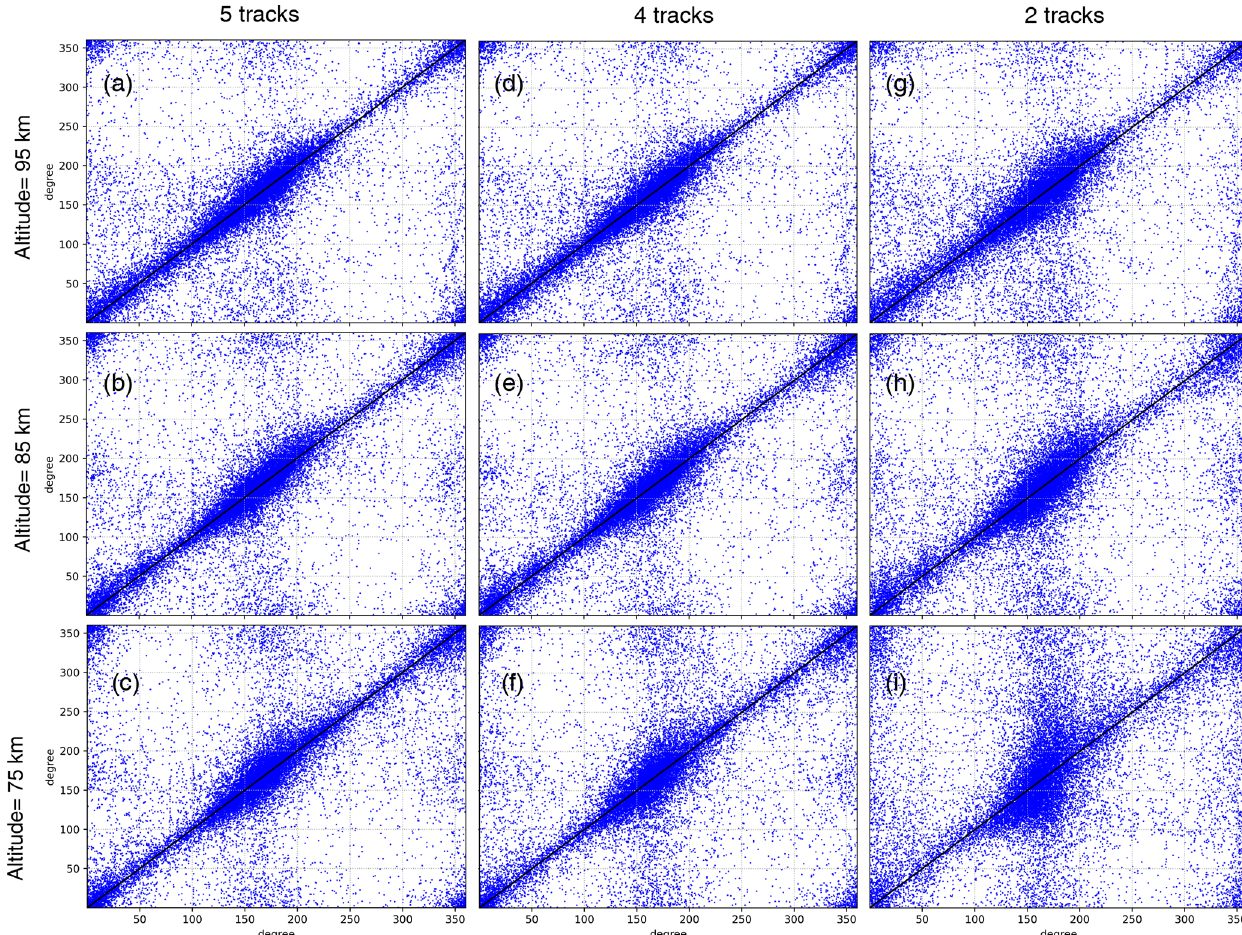
Figure 12. Scatter plots of wave direction of the first wave component for 5 tracks (a–c) , 4 tracks (d–f) , and 2 tracks (g–i) on the y axis versus the reference of 15 tracks on the x axis at an altitude of 75km (c, f, i) , 85km (b, e, h) , and 95km (a, d, g) . A black 1:1 identity line is added for the comparison. Note that points around (0, 360 ◦ ) and (360, 0 ◦ ) appear simply due to a mapping of 360 ◦ on the y or x axis in